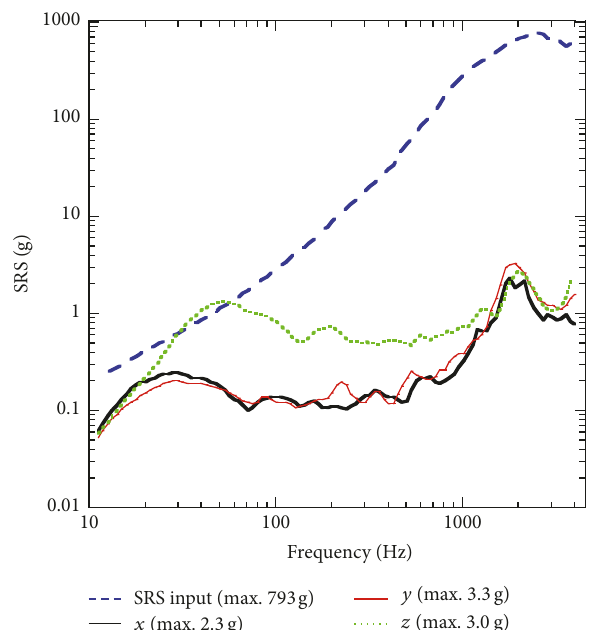
Figure 13: Results for shock test of RWA isolation system on each axis